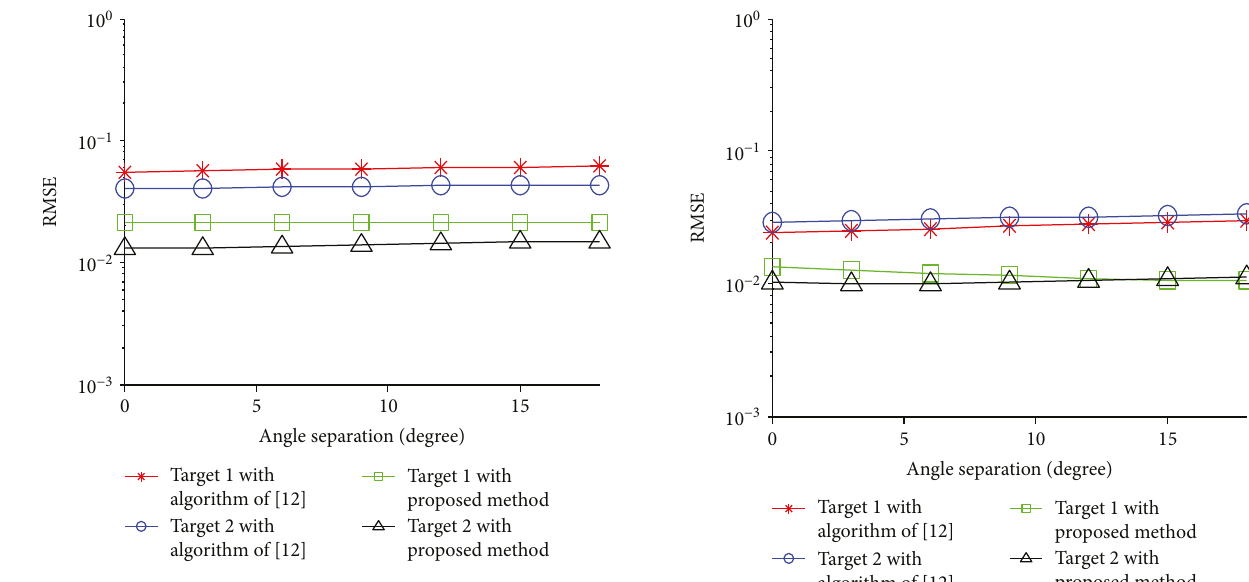
Figure 6: RMSE of azimuth estimation versus angular separation.